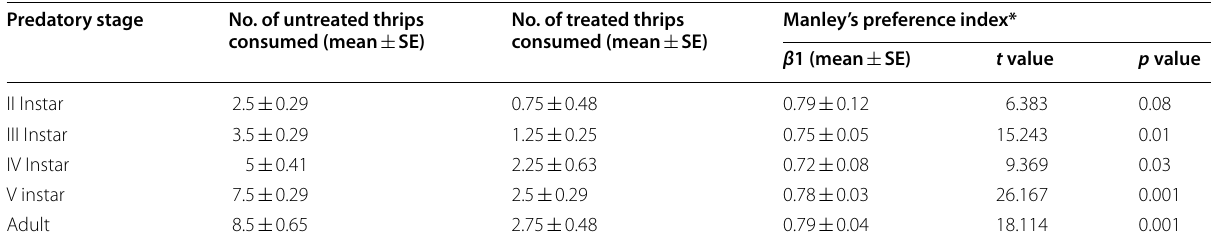
Table 3 Prey preference of different nymphal instars and adult of B. pallescens fed on Vl-8 treated and untreated thrips recorded after 24